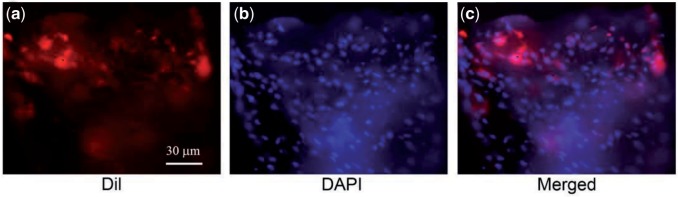
Fluorescence micrographs of neo-tissues 6 weeks after implantation of porous scaffolds seeded by BMSCs with their cell membranes labelled by DiI. (a) DiI-labelled cells (red) in the neo-tissue zone; (b) the same viewing field with cell nuclei stained by DAPI (blue); (c) the merged image of (a) and (b).